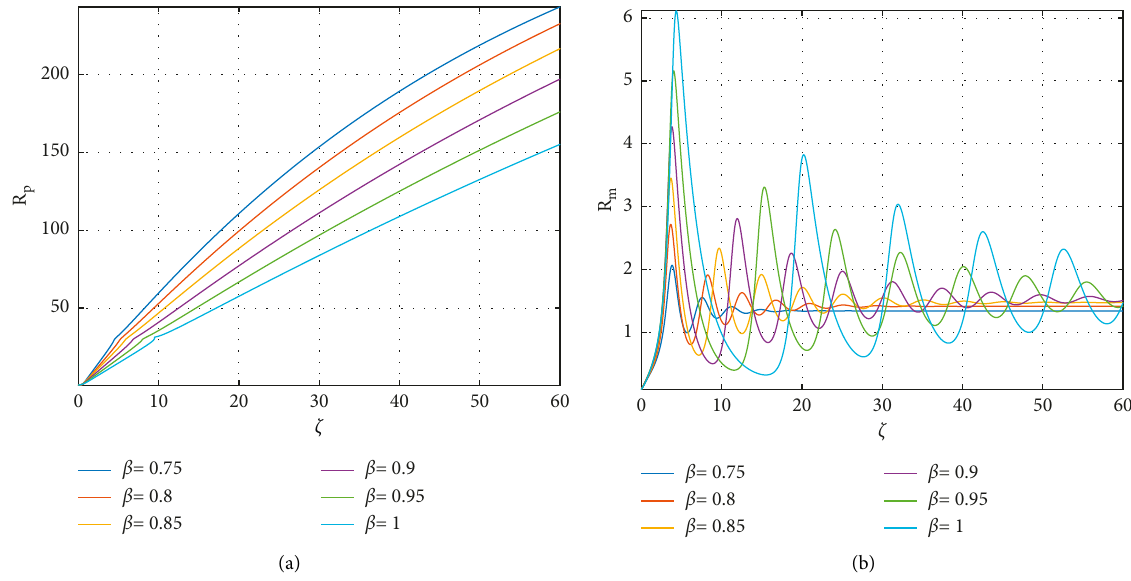
Figure 10: Two-dimensional illustration of the pneumonia recovered R multiple fractional orders β ∈ [ 0 , 1 ] .